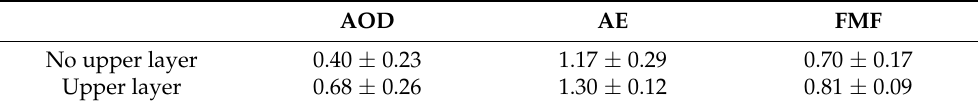
Table 2. Statistics of the mean values and standard deviations of the AOD at 500 nm, the AE, and the FMF during cases with layers and with no layers measured with a sunphotometer from 1 December 2014 to 10 January 2015.